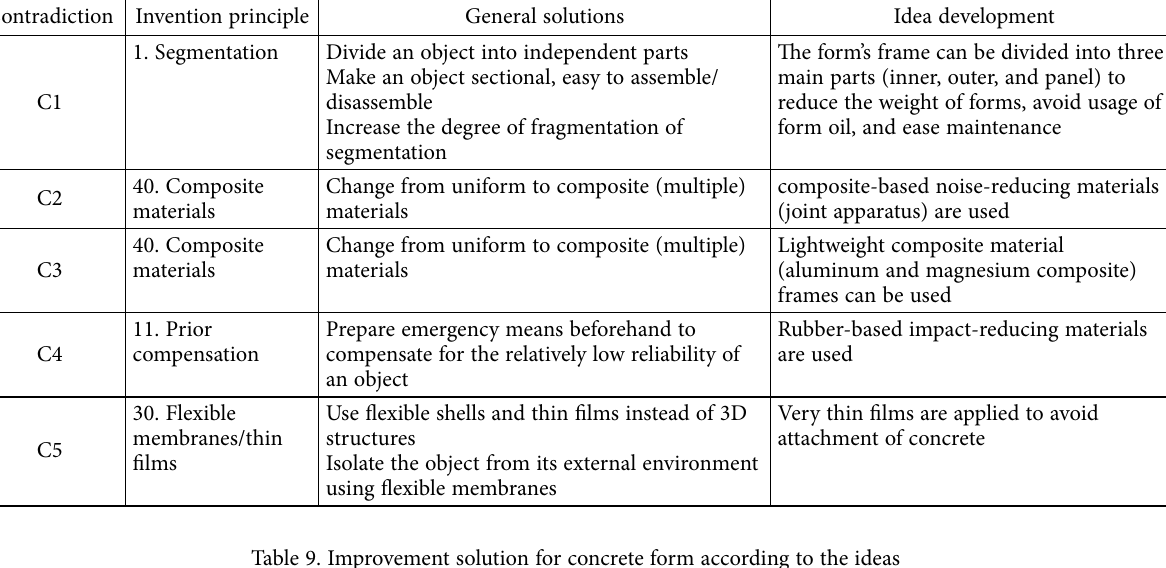
Table 9. Improvement solution for concrete form according to the